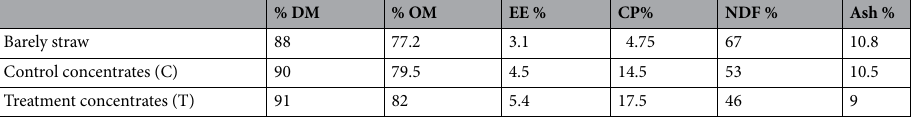
Table 1. The chemical composition (%) of control (C) and treatment (T) concentrates mixtures and barely straw. DM dry matter, CP crude protein, EE ether extract, NDF neutral detergent